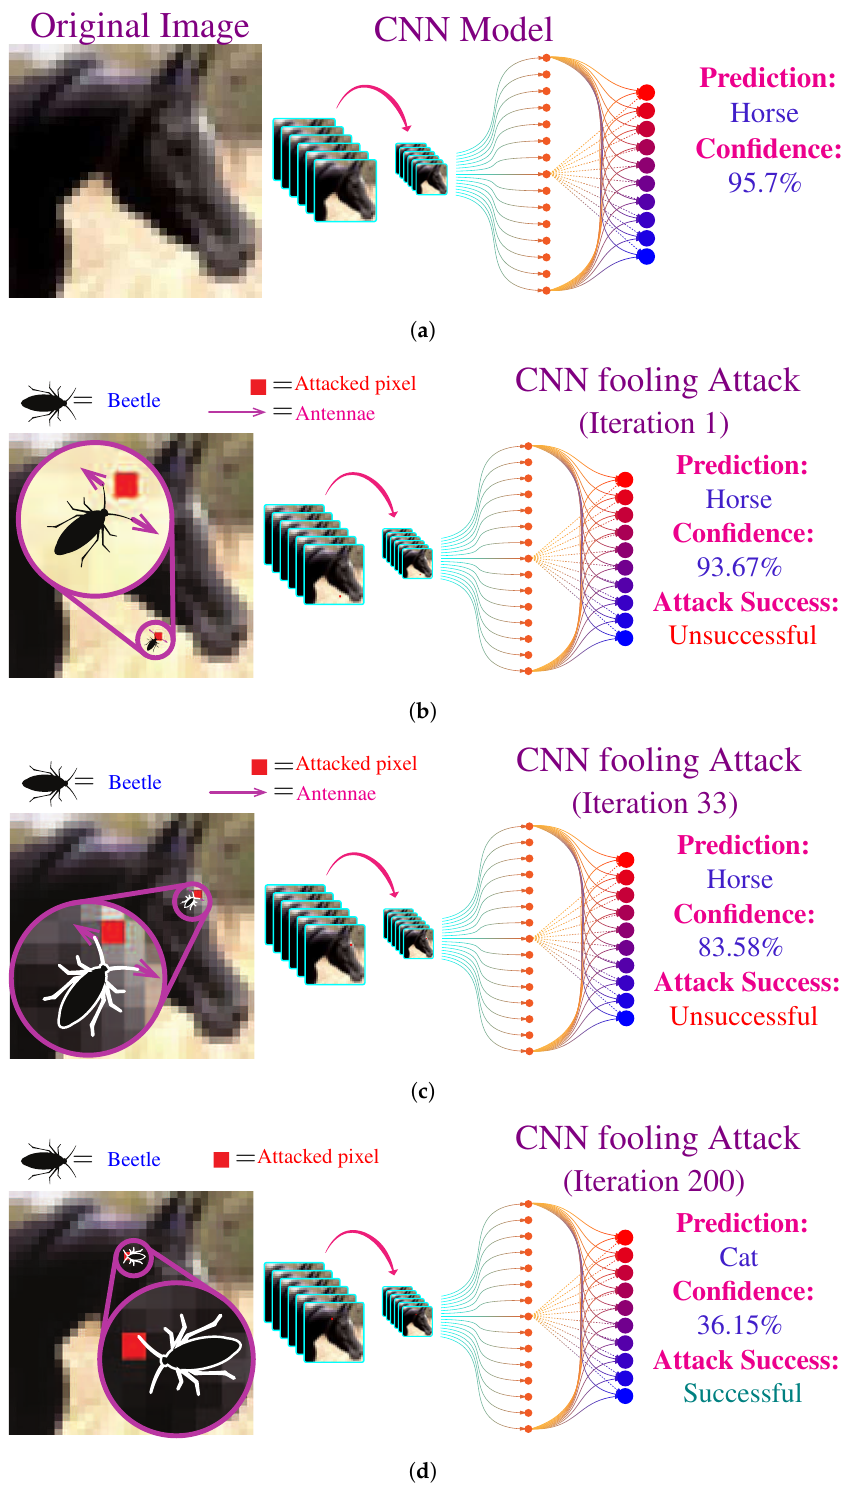
Figure 6. Illustration of the CNN attacking algorithm. ( a ), The original input image to the CNN model: the image contains a horse, and the CNN’s prediction is also a horse with the confidence of 95.7%. ( b ), First iteration of the fooling attack: the modified image reduced the confidence to 93.67% with just modification of single pixel. ( c ), 33rd iteration of the fooling attack: after searching for a while, the algorithm found a pixel which reduced confidence to 83.58%. ( d ), 200th iteration of the fooling attack: the algorithm finally found a pixel which fools the CNN to classify the image as a